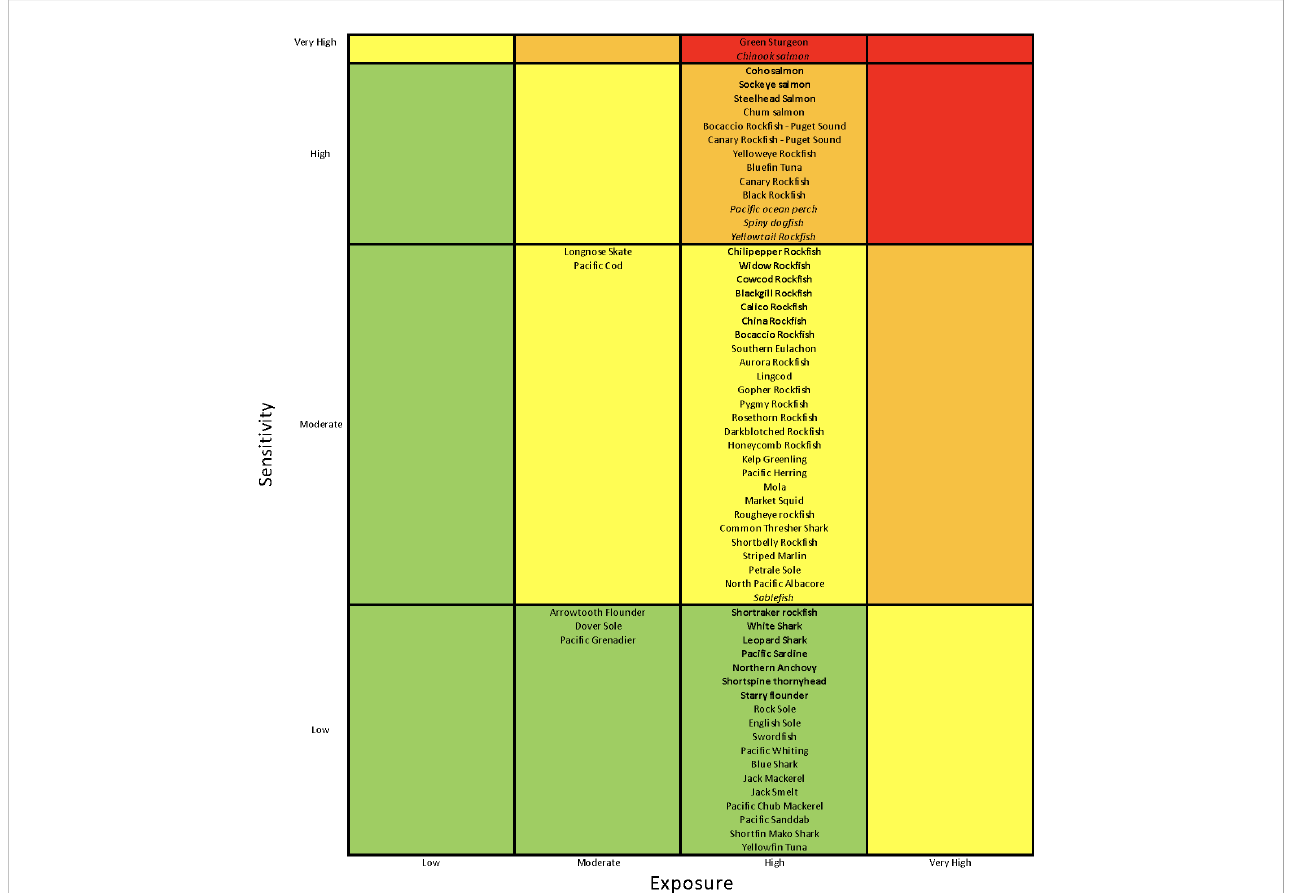
FIGURE 2 Vulnerability categorization for California Current LME species. Vulnerability categories are colored from green (Low) to red (Very High). Species or stocks in bold had a >25% chance of being placed in the next highest vulnerability category in our bootstrap analysis; those in italics had a >25% chance of being placed in the next lowest vulnerability category in that